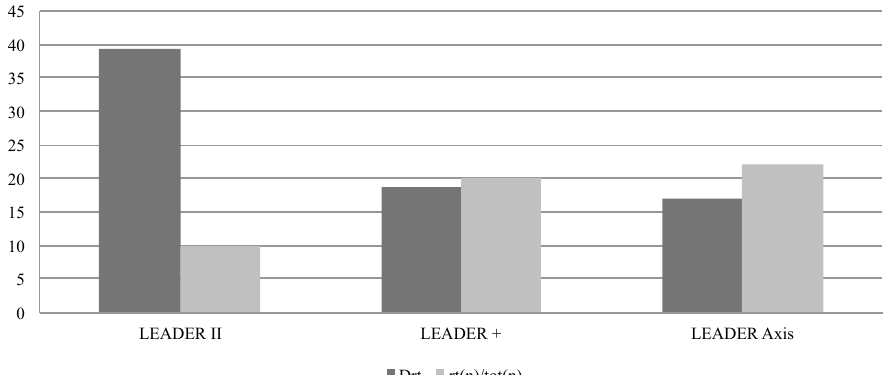
Figure 6. Comparison between the trend of regional-transnational density and trend of the propor- tion of regional-transnational